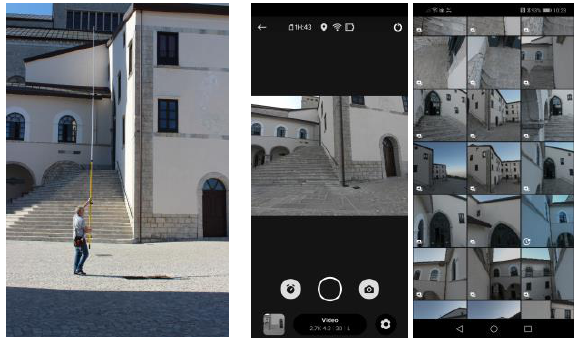
Figure 5. Mode of acquisition and recording of photographic